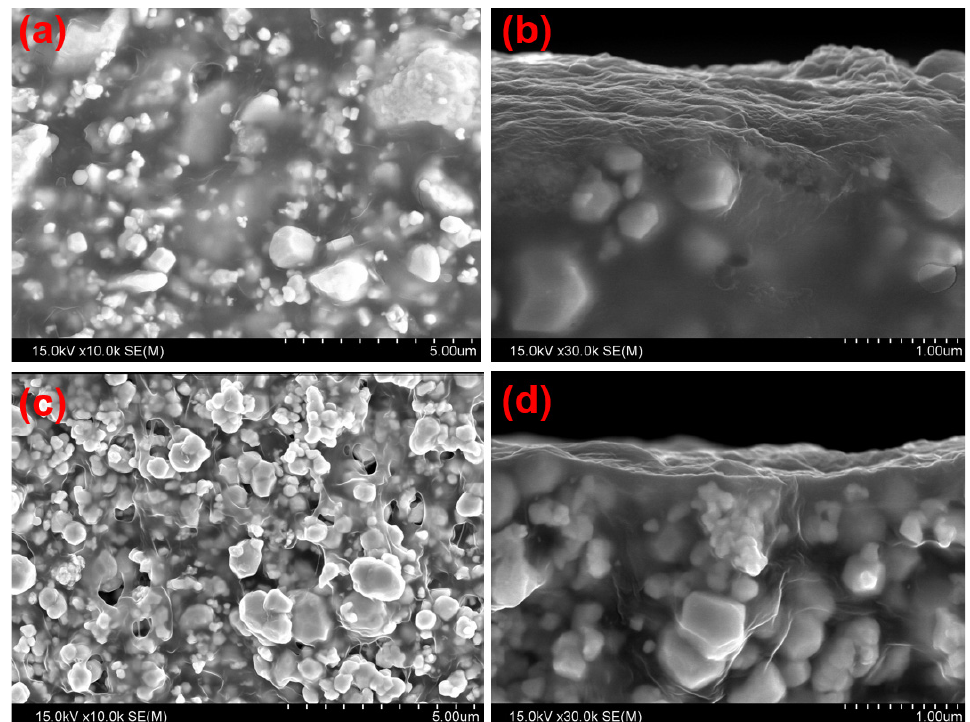
Figure 6. Cross-sectional comparison results of the shielding films with the emulsion polymer and powder polymer: ( a , b ) Individual agglomeration of tungsten particles when using the emulsion polymer; ( c , d ) Uniform dispersion of the tungsten particles when using the powder polymer.